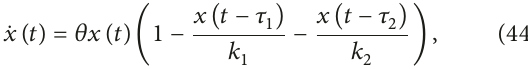
(b) Numerical solution of the DLDEM with two delays (45) using the estimatedparametervalues.Thestarsarethesimulatednoisydatabyadding noises to the DLDE solutions at 𝑛 + 1 = 101 equally spaced time points in [0,10] by step size ℎ = 0.1 with 𝜃 1 = 0.5,𝜃 2 = 0.7 , 𝜃 3 = 0.12 , 𝜏 1 = 2 , and 𝜏 2 =